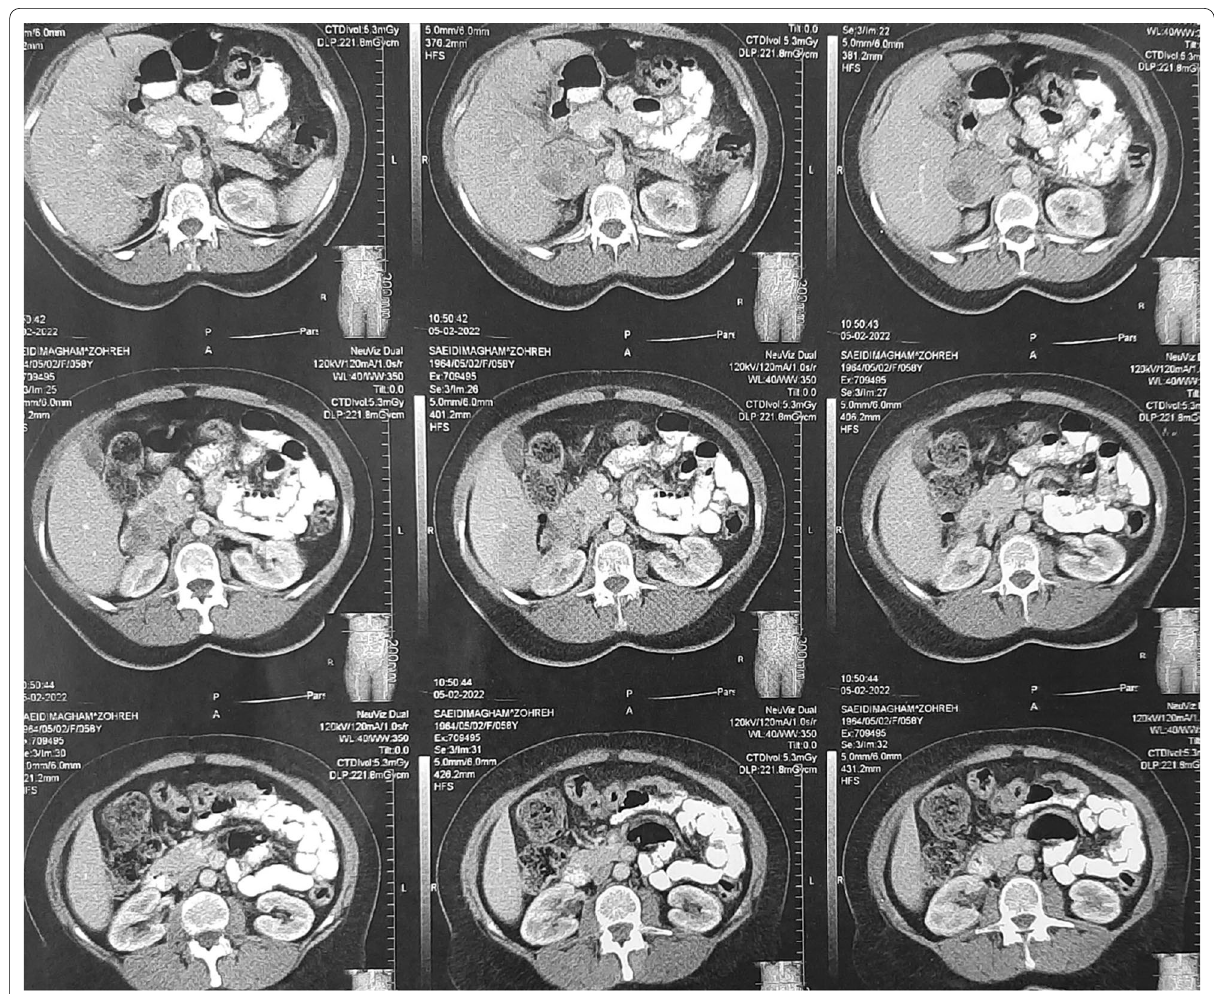
Fig. 1 Large nonfunctional adrenal mass in 58-y-old